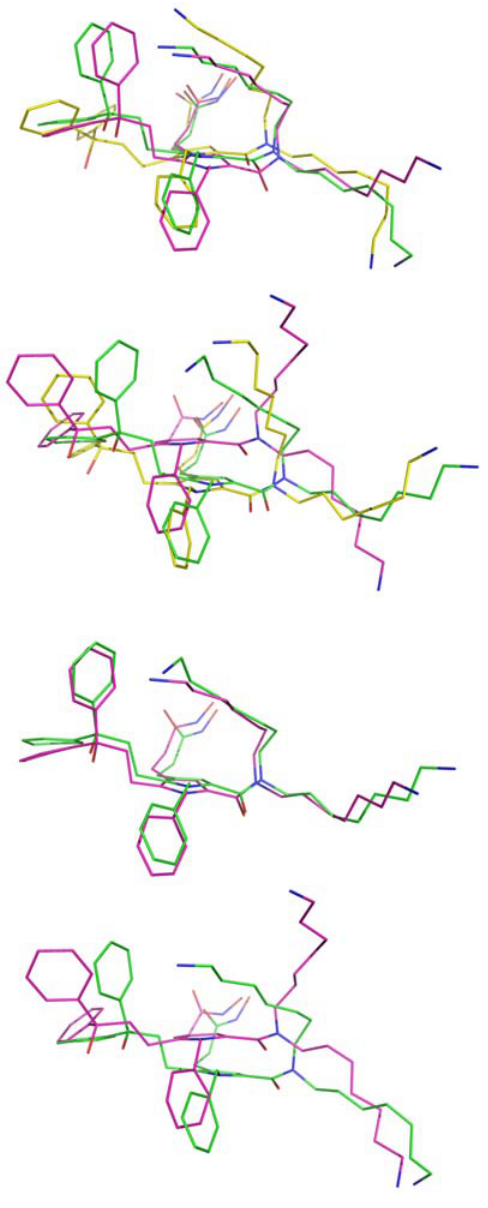
Figure 4. Overlays of AHP conformations of the three most populated clusters from the MMDSs. A (row 1): Clusters 1 (green), 2 (magenta), and 3 (yellow) from the first-round; B (row 2): Clusters 1 (yellow), 3 (green), and 5 (magenta) from the second-round; C (row 3): Cluster 2 (magenta) of the first-round and Cluster 3 (green) of the second-round; D (row 4): Cluster 1 (green) of the first-round and Cluster 5 (magenta) of the second-round.